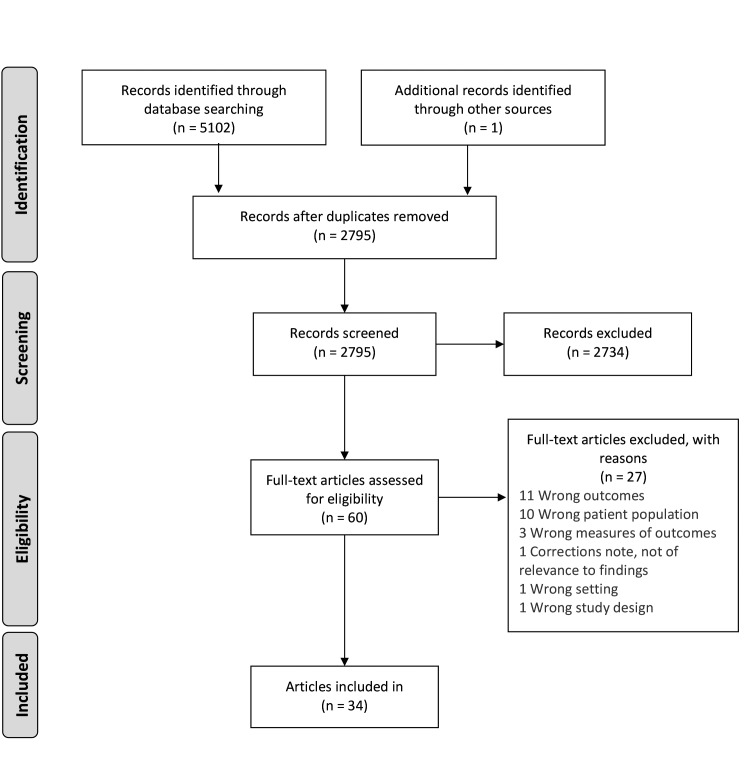
PRISMA flow diagram [15].